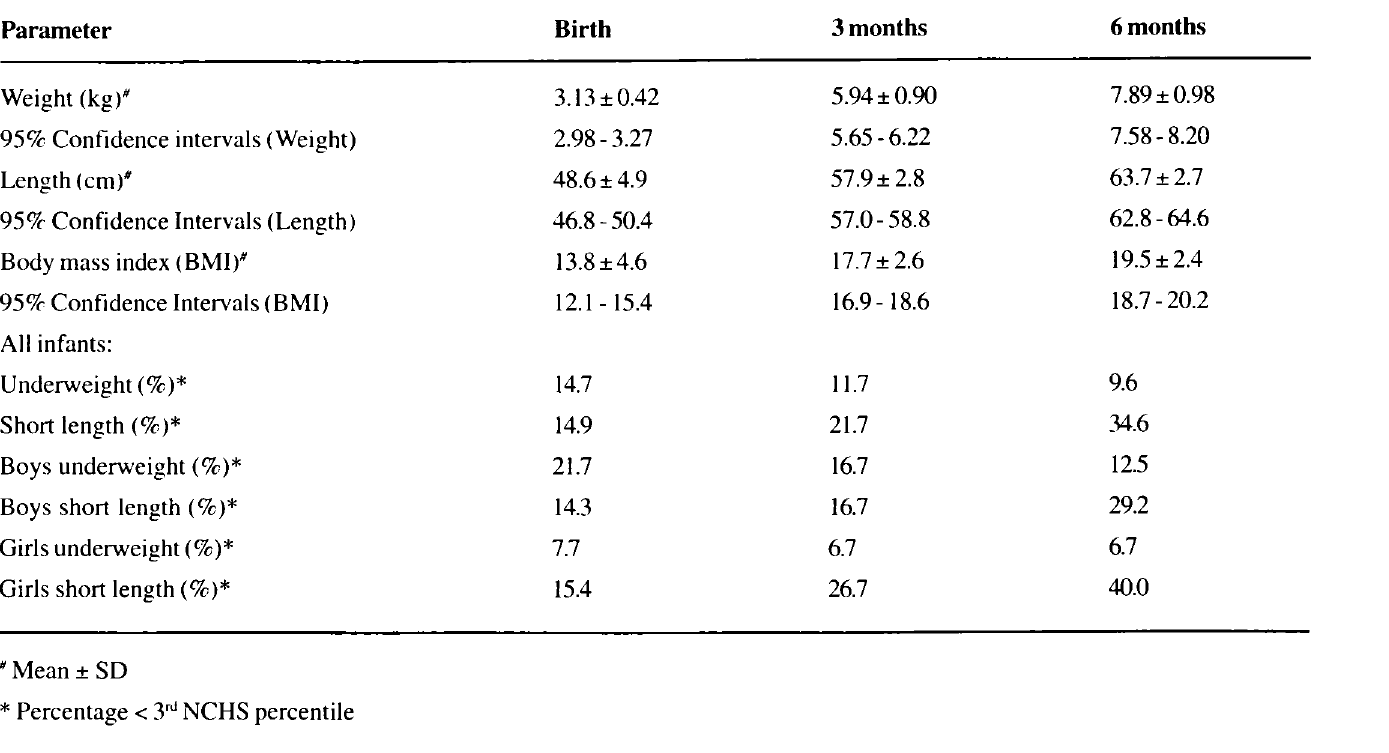
Table 3. Anthropometric variables of the Dikgale infants studied at birth, 3 months and 6 months